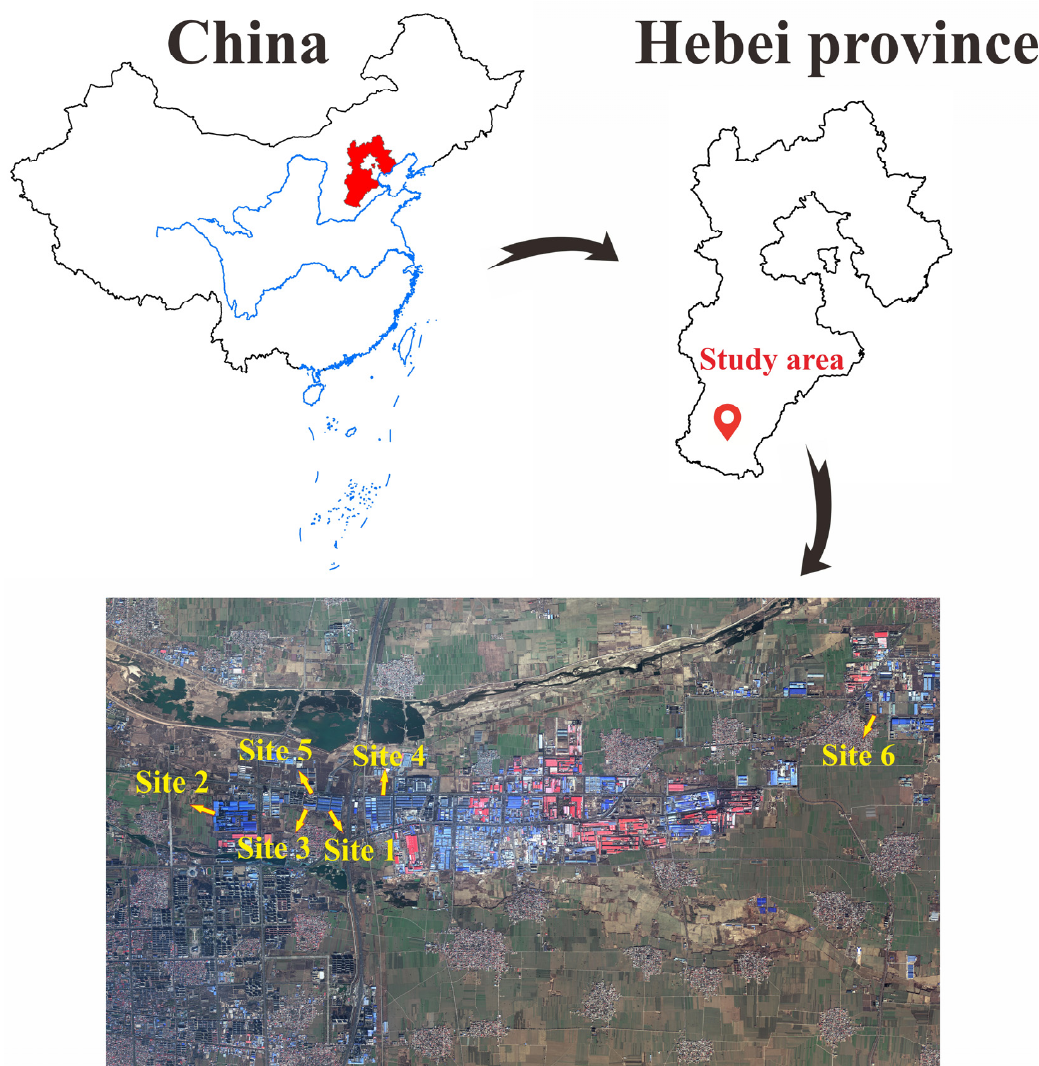
Figure 1. Location map of sampled enterprises. (Enterprise 1:36°53 ′ 56.11 ″ N,114°32 ′ 40.95 ″ E;